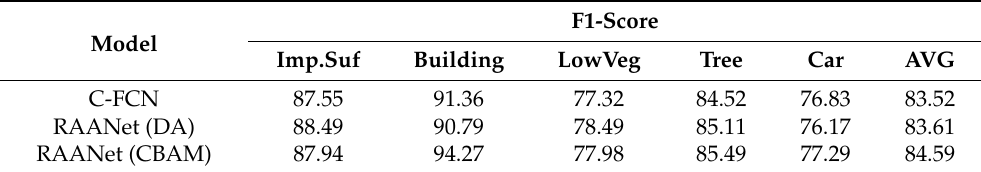
Table 9. Quantitative comparison of F1-score with C-FCN on ISPRS Vaihingen challenge test